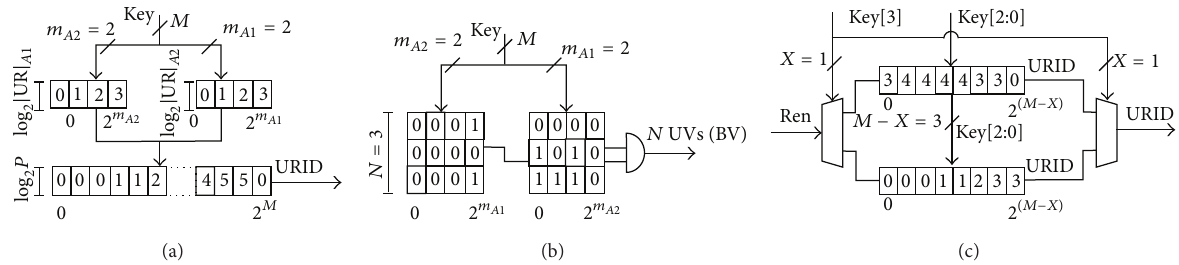
Figure 11: Stitching options: (a) UR-based horizontal stitching, (b) UV-based horizontal stitching, and (c) vertical stitching.